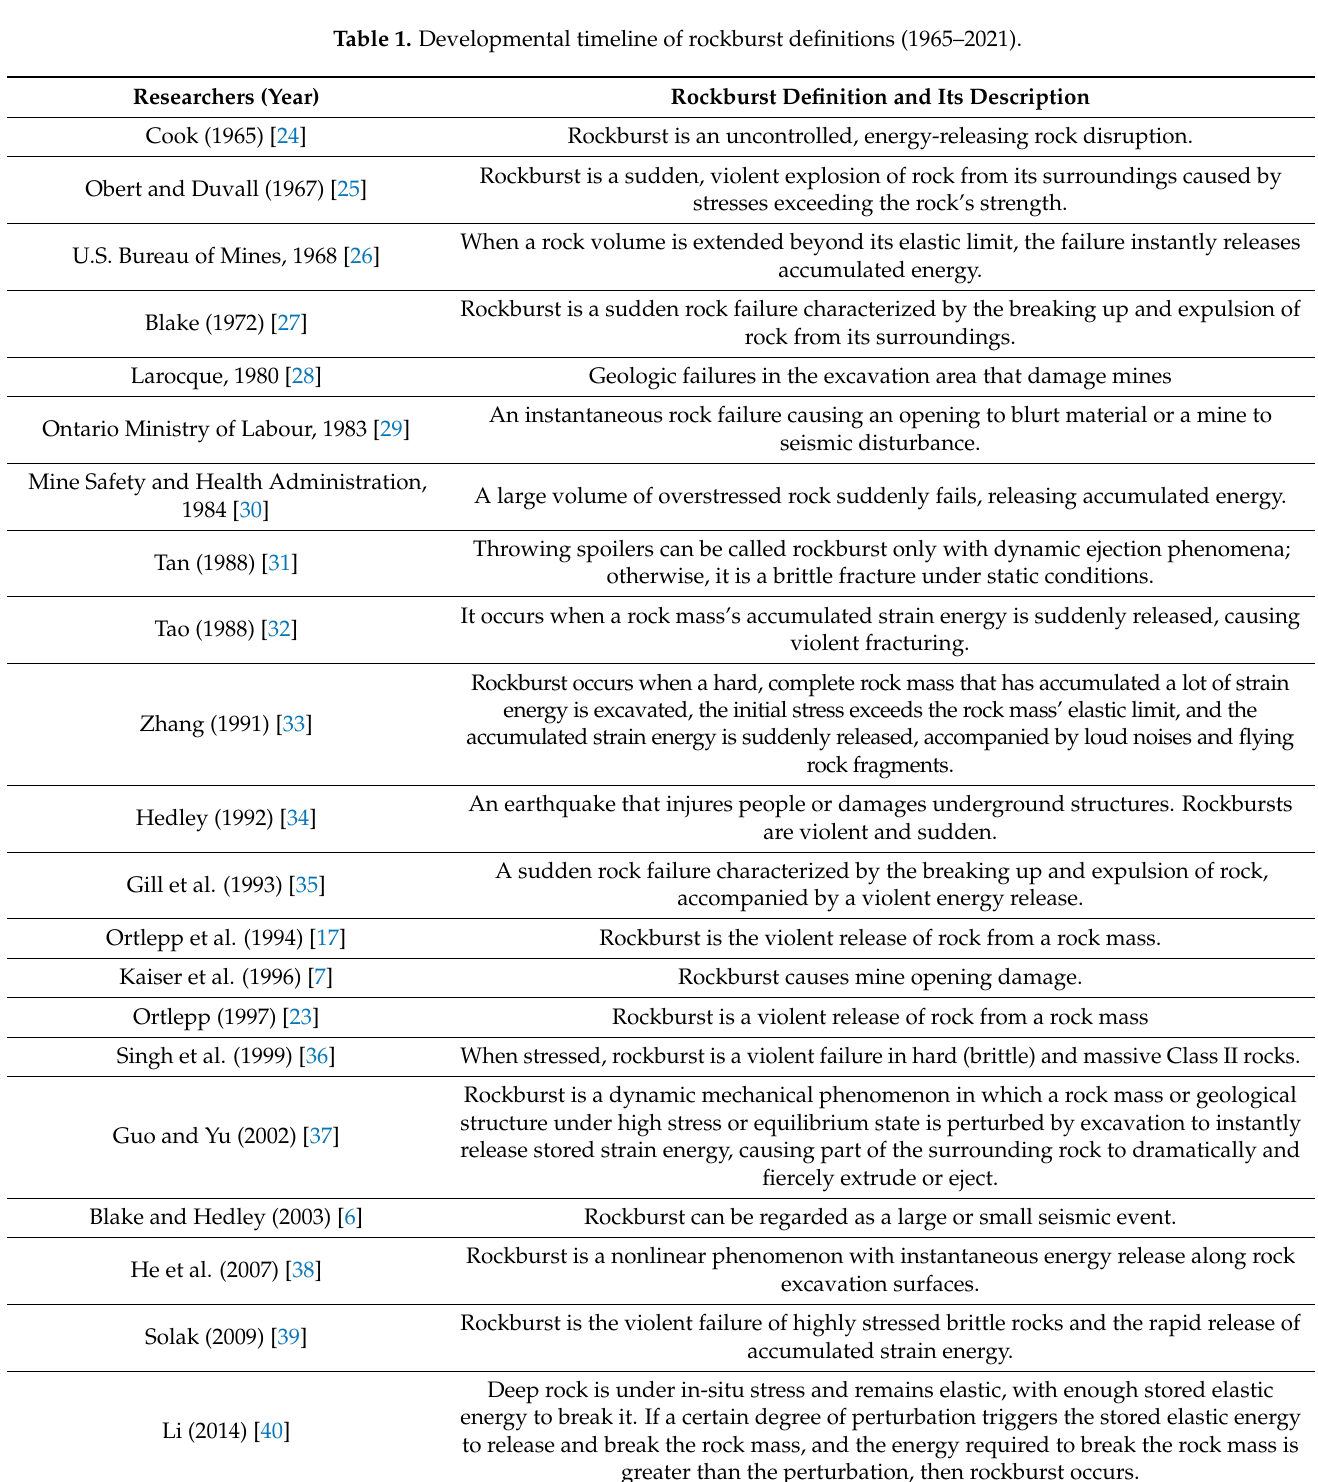
Table 1. Developmental timeline of rockburst definitions